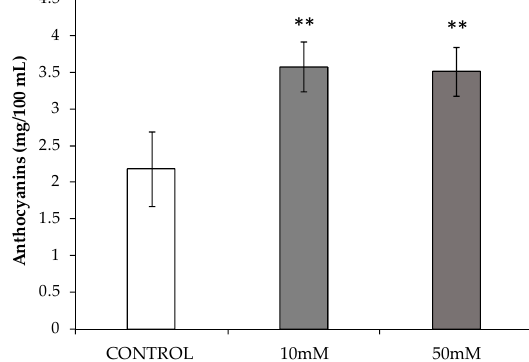
Figure 3. Total anthocyanin content was measured as mg of cyanidine-3-glucoside in 100 mL of grape juice from CONTROL and HB-treated Vitis vinifera L. cv Alicante Bouschet plants. Samples were collected at time 7 DA-D. Asterisks (**) indicate statistically significant differences between control and treated plants at each concentration with p < 0.01.